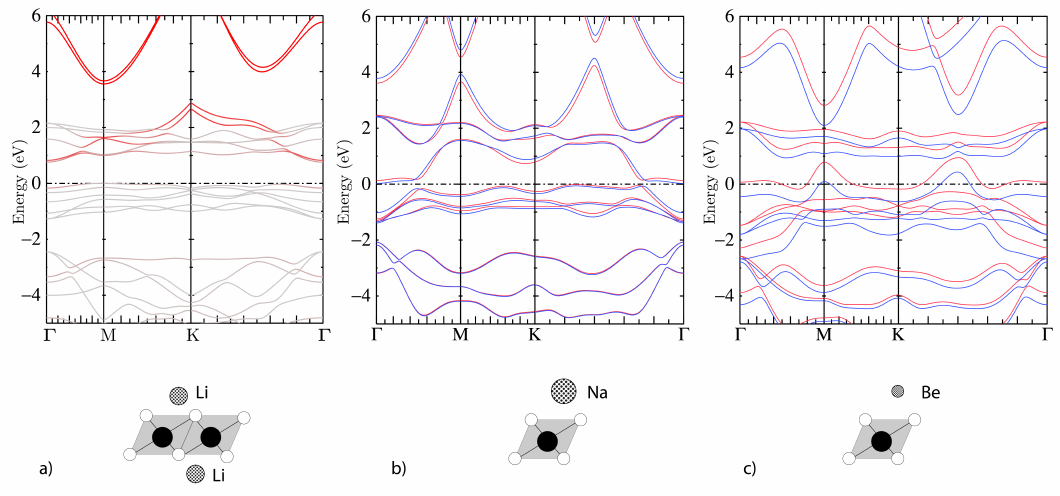
Figure 6: (a) LiCoO mono-layer with the Li atoms forming 1D chain (Red color is 2 the Li projected band); (b) NaCoO ; (c) BeCoO band structures ( red / blue bands 2 2 denote the majority and minority spins).